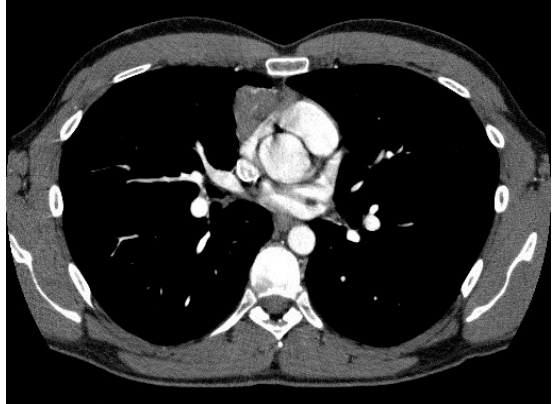
A significant correlation between CT scan parameters and the WHO and Suster and Moran histological classifications was observed. In particular, moderately differentiated tumors (WHO B3) had a significantly higher incidence of irregular shape and contours ( p = 0.002 and p = 0.001, respectively), mediastinal fat invasion ( p = 0.05) and pericardial contact ( p = 0.036) (Figures 1 and 2), (Supplementary Table S2).